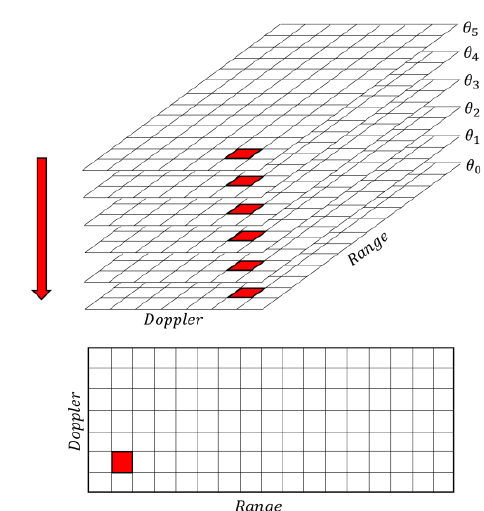
Fig. 3. Visualisation of Cube Compression for Range- Doppler